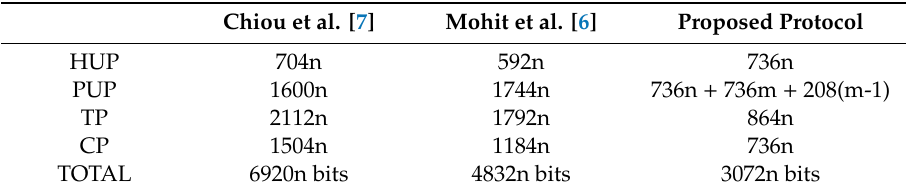
Table 7. Comparison of communication costs in bits.